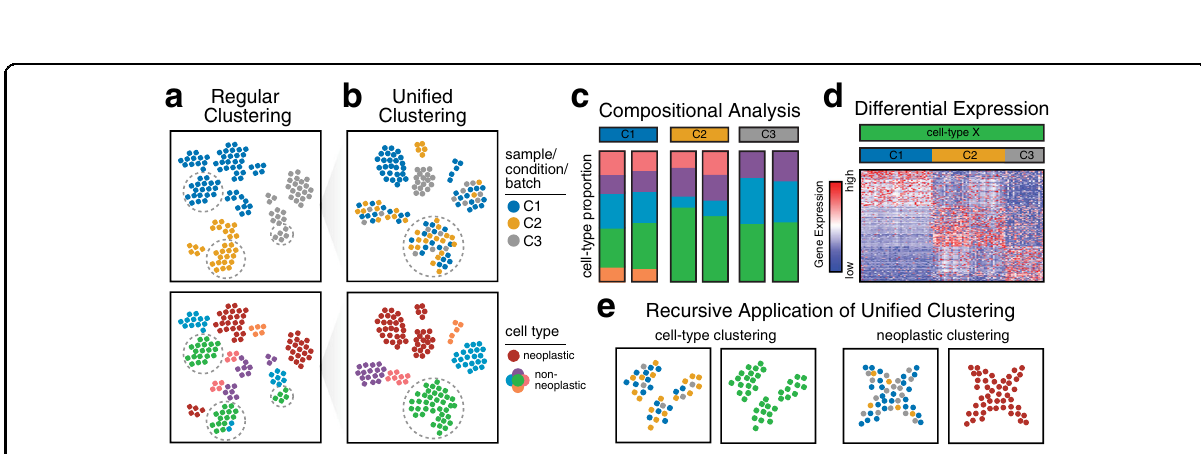
Fig. 3 Uni fi ed clustering analysis. a The clustering of cells from different samples across diverse conditions may result in cells being aggregated by sample, condition, or other technical factors such as the batch rather than the cell types of interest. The top illustration shows a 2D reduced dimensional representation (e.g., tSNE) in which each point is a cell and is colored according to the sample, condition, or batch label. The bottom illustration shows the same 2D embedding colored according to cell type. Cells are aggregated according to the sample, condition, or batch, rather than the cell type, making the identi fi cation of shared cell types dif fi cult. b Uni fi ed clustering analysis results in cells that are appropriately aggregated by cell type, particularly for nonneoplastic cell types. c After the identi fi cation of common cell types, additional downstream analyses may be performed. For example, compositional analysis comparing nonneoplastic cell-type proportions across three conditions, each with two replicates, can be performed to show high correspondence within replicates but differences across conditions. d Differential expression analysis can also be applied to one cell type, comparing each condition to all others, identifying differentially upregulated genes in each condition. e Uni fi ed clustering analysis may be applied recursively to identify additional subtypes or states within nonneoplastic cell types (left) or shared transcriptional states among neoplastic cells across